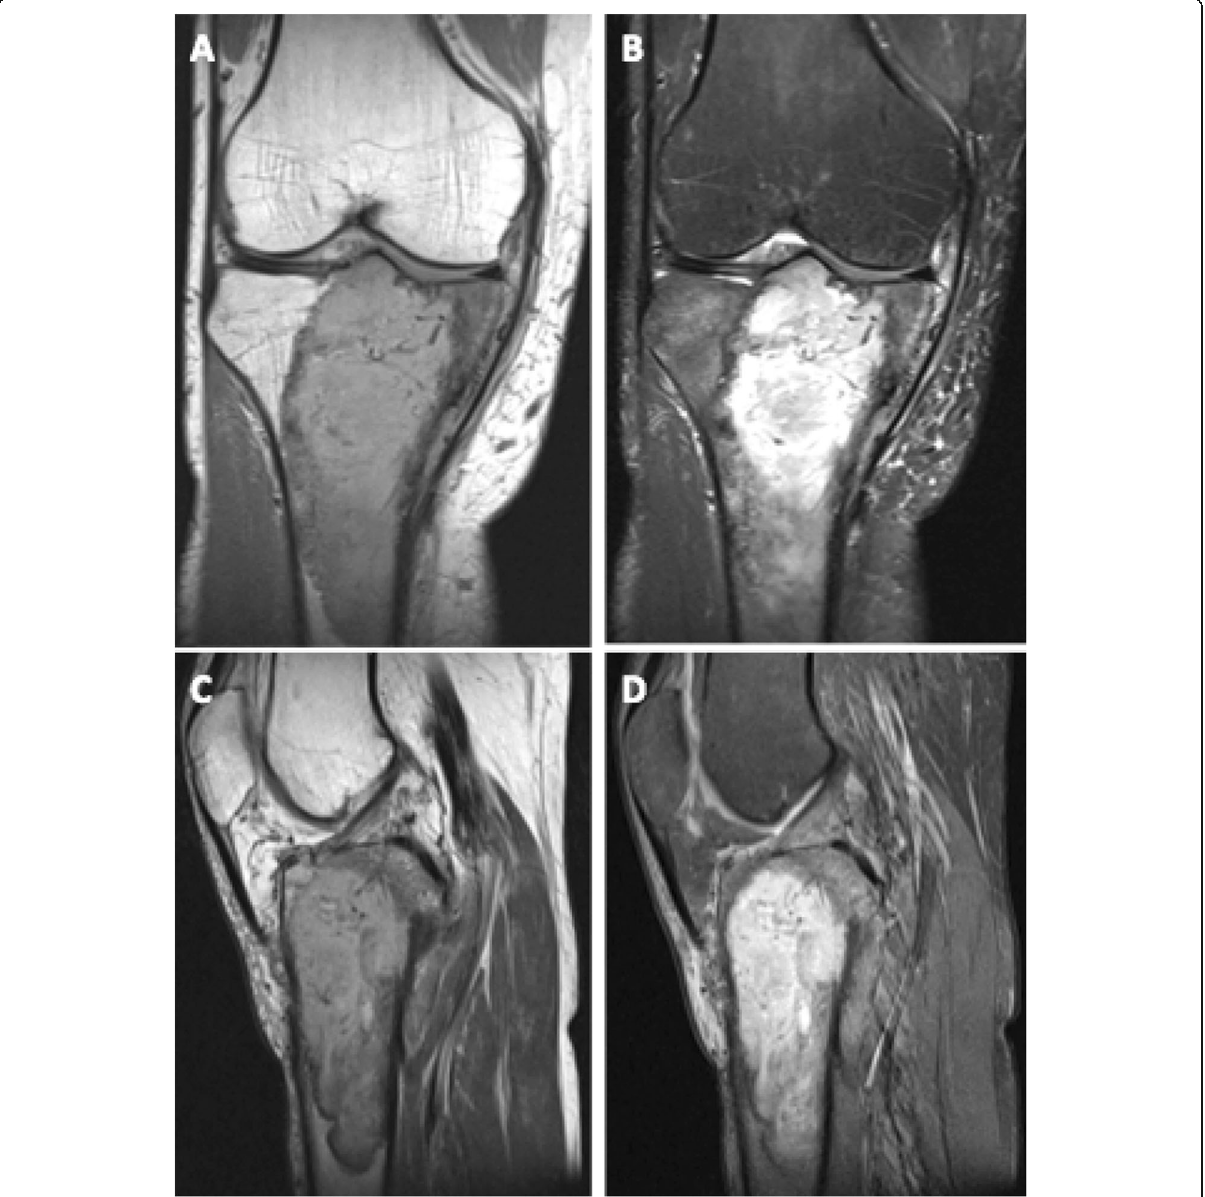
Fig. 2 a Coronal Proton Density b Coronal T2-weighted fat-suppression c Sagittal proton density d Sagittal T2 -weighted fat-suppression magnetic resonance images of a right knee in a 39 year-old male demonstrating a well-circumscribed marrow-replacing lesion within the proximal tibia that extends from the articular surface distally. An associated periosteal reaction is evident as well as cortical thinning and destruction. There is also a soft-tissue component to the mass that extends